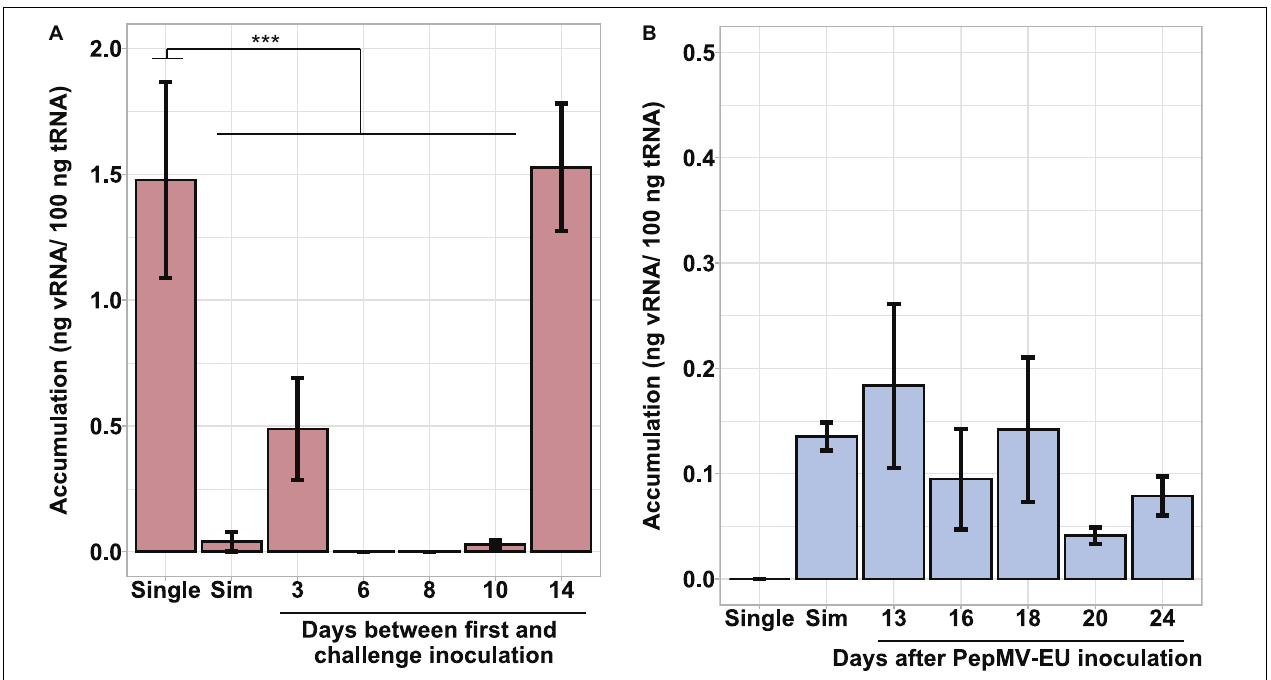
FIGURE 2 | Effect of PepMV-CH2 over-infection on virus accumulation. PepMV-CH2 (A) and PepMV-EU (B) accumulation was measured in plants pre-inoculated with PepMV-EU and challenged with PepMV-CH2. Single PepMV-CH2 and simultaneous infections with PepMV-EU + PepMV-CH2 were included as controls. Over-inoculations were carried out at different times after pre-inoculation (3, 6, 8, 10, and 14 days). Viral accumulation was determined for three plants for each time point by absolute RT-qPCR and shown as ng viral RNA/100 ng total RNA; each bar represents the mean and its standard deviation. Asterisks show significance level (*** p < 0.001; ns, no